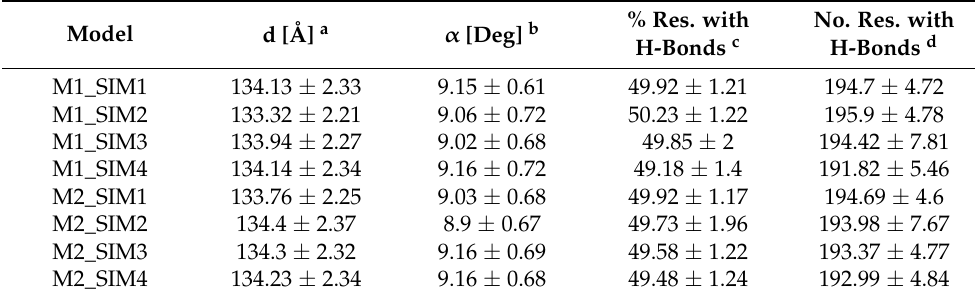
Table 1. Structural properties of the obtained models of amyloid fibrils measured during AA MD simulation. Model